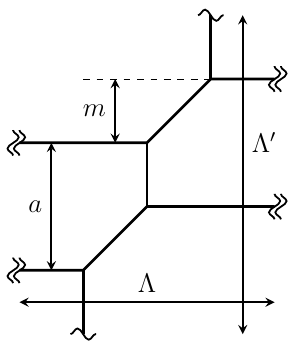
Figure 1 . Compacti(cid:12)ed ( p; q )-brane web corresponding to the 6 d U(2) gauge theory with adjoint hypermultiplet compacti(cid:12)ed on T 2 . The wavy (double wavy) lines are understood to be identi(cid:12)ed with each other. The parameters of the gauge theory are encoded in the distances between the branes: a is the Coulomb modulus, m is the mass of the adjoint (cid:12)eld, (cid:3) is the exponentiated com- plexi(cid:12)ed coupling, and (cid:3) 0 is the exponentiated complex structure modulus of the compacti(cid:12)cation torus T 2 .